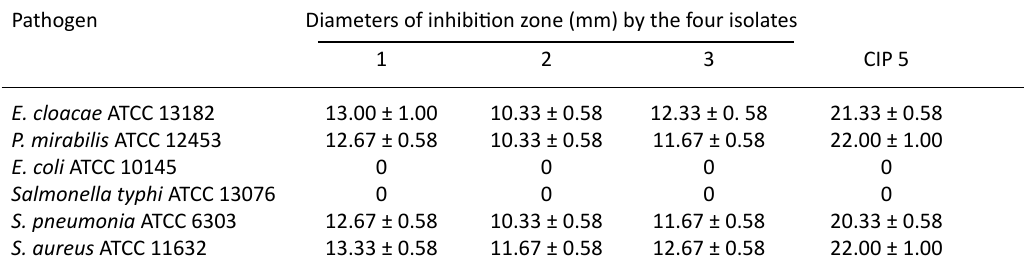
Table 3. Classification of bacterial strains according to 16S rRNA (results obtained from BLAST/NCBI) Table 4. Antimicrobial activity of the three isolates of B. lichinifomis against test pathogens Pathogen